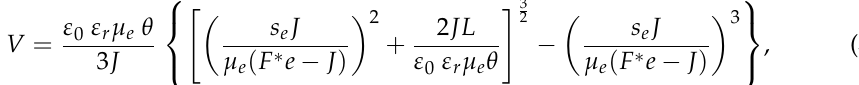
ergy was equal to ħω = 1.651 eV = E g + 76 meV. For the lowest photon flux, F = 1.39 × 10 12 cm − 2 s − 1 , the